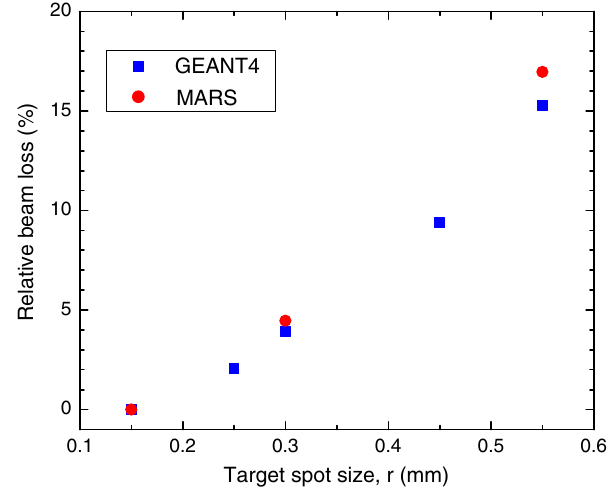
FIG. 4. Relative loss of the number of pions at the downstream face of the lithium lens as a function of the beam rms size at the target. Equal size in both horizontal and vertical planes is assumed. The software cut on pion momentum was limited to 2.5% around the central momentum of 3 . 1 GeV =c . Note that the baseline design considers a 0.15 mm beam spot size at the target.